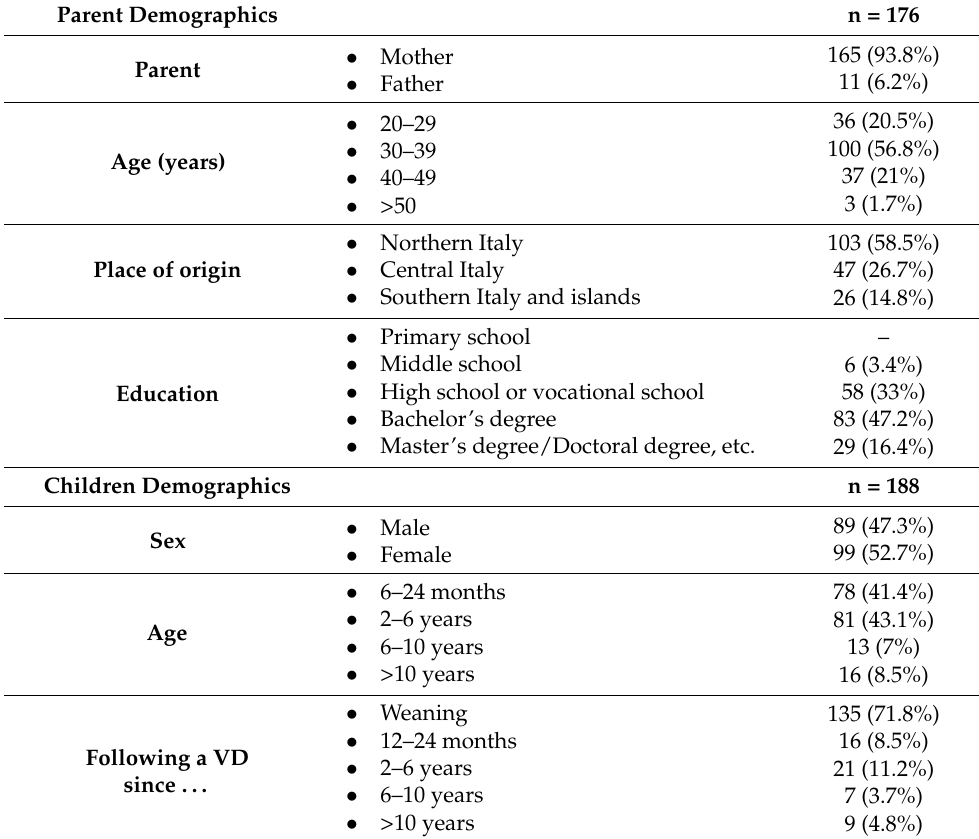
Table 2. Demographics of parents and